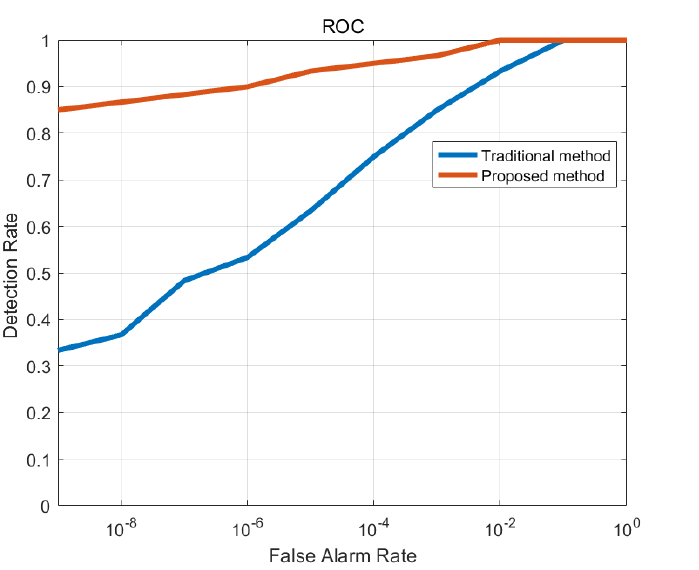
Figure 12. Comparison of ROC curves of the traditional and proposed detection